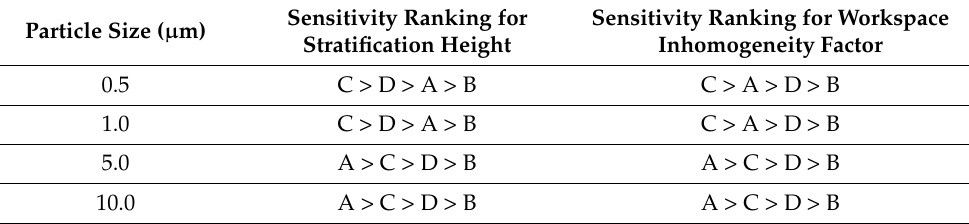
Table 7. Sensitivity sorting information of influence factors of stratification height and workspace inhomogeneity